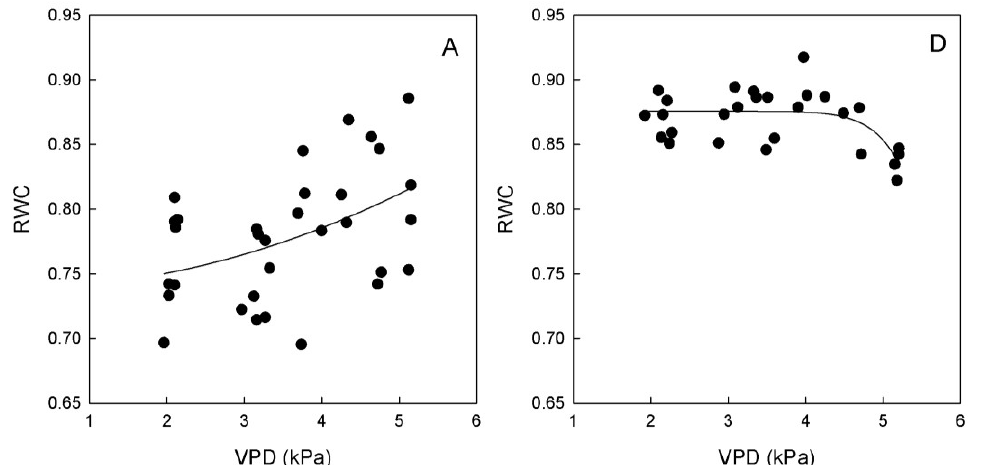
Figure 5. Relationships between relative water content (RWC) and vapor pressure deficit (VPD), stomatal conductance (g ), or transpiration rate (T) in leaves of ( A – C ) ‘Biancolilla’ s and ( D – F ) ‘Cerasuola’ olive trees during a typical summer day in Sicily. In ‘Biancolilla’, g = exp(1.95 + 3.64 RWC); R 2 = 0.234, p = 0.005; T = 4.29 RWC 6.68 ; R 2 = 0.500, s p < 0.001. In ‘Cerasuola’, RWC = 0.88 + 0.0007 VPD 15 ; R 2 = 0.394, p = 0.003; T = 0.88 − 0.014 RWC 2 ; R 2 = 0.181, p = 0.027. Models tested by regression analysis and best equation chosen according to Schwarz’s Bayesian Information